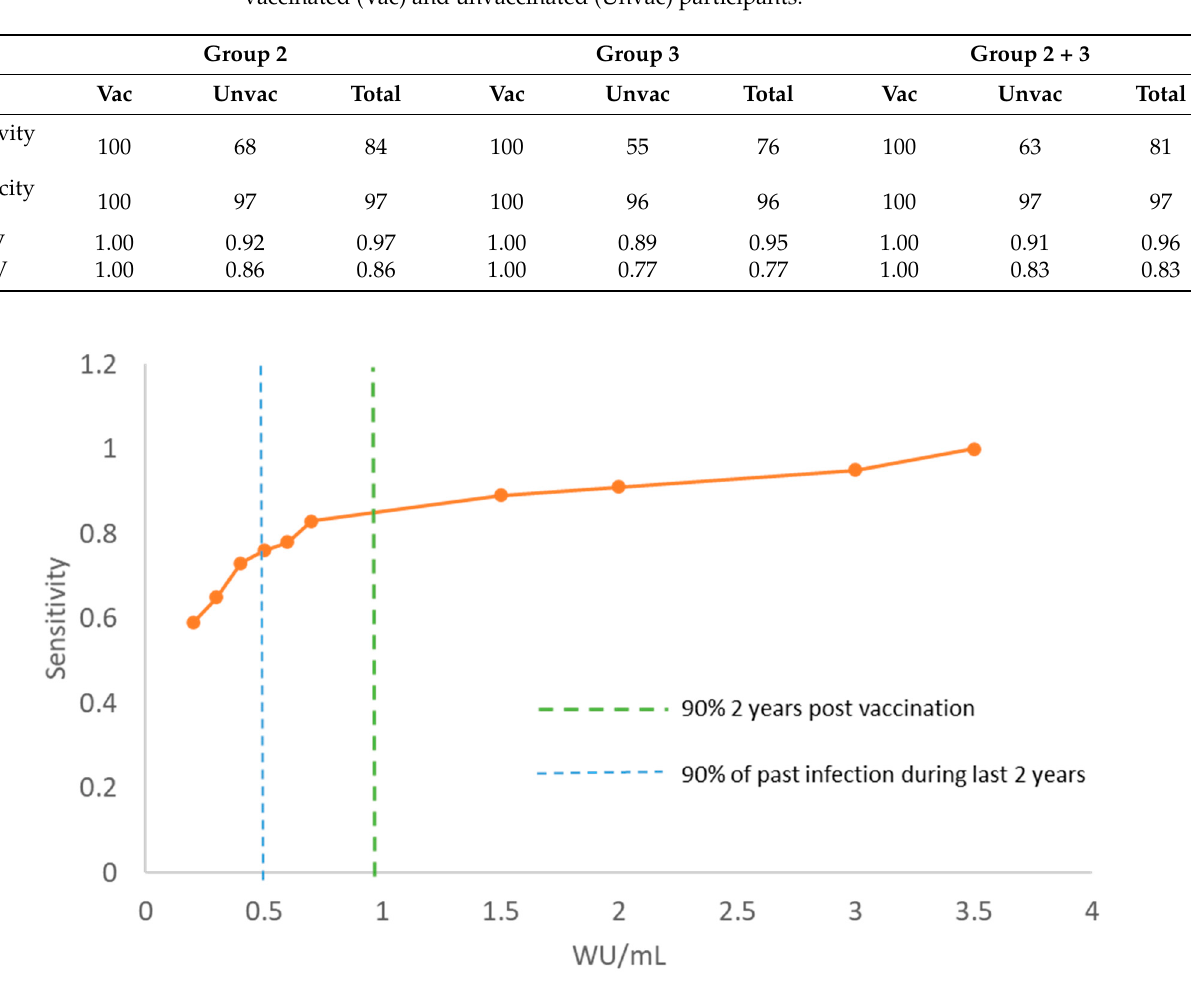
Figure 4. Positive correlation between IgG titer (WU/mL) and the sensitivity from DBS sample (orange line). Dotted lines represent the level of IgG of which 90% of people with an infection (blue) or vaccination (green) will be above.